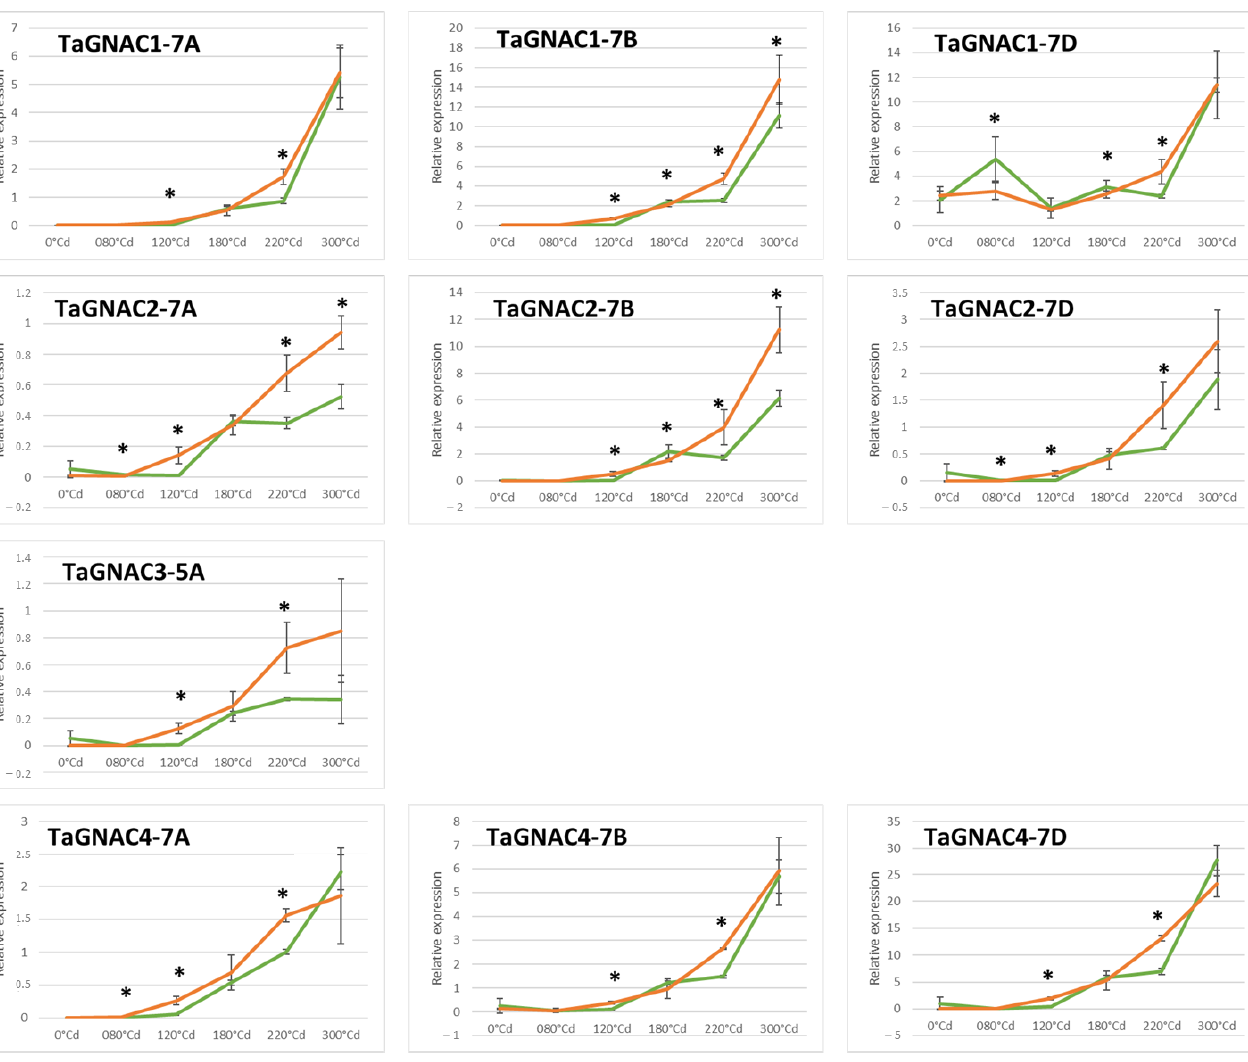
Figure 5. Expression profile of the homeologs of TaGNAC1 , TaGNAC2 , TaGNAC3 , and TaGNAC4 in bread wheat grain during six developmental stages. The expression was monitored in control (19 °C, green curve) and moderate thermal stressed condition (27 °C during 10 days after anthesis, orange curve). * = significative difference between control and stressed conditions ( T test, p -value < 0.05).